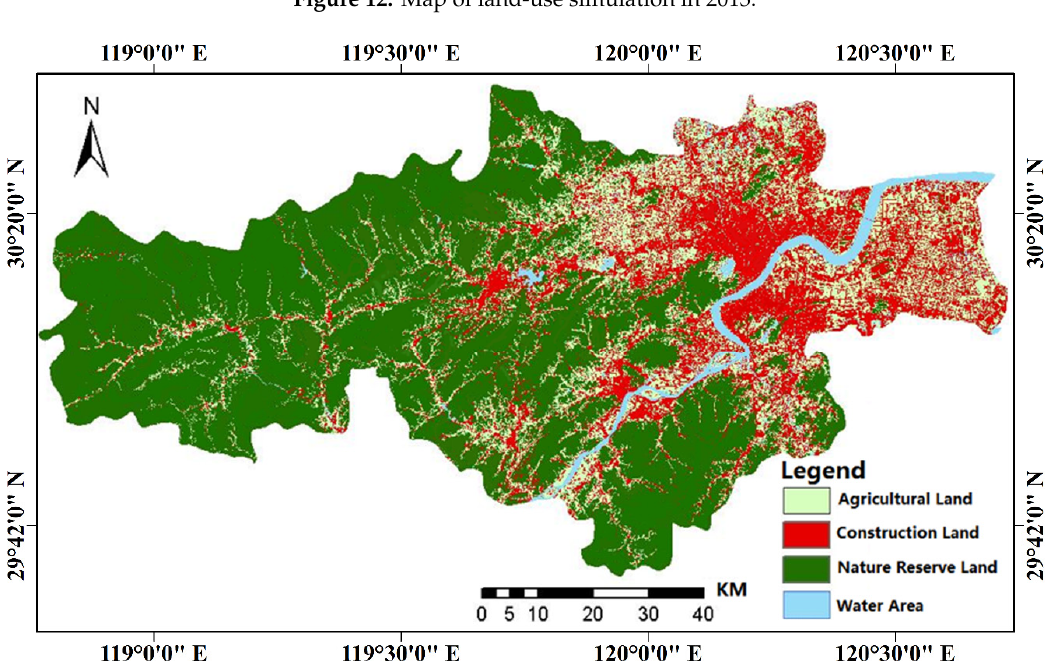
Figure 13. Classification map of remote-sensing images in 2013.